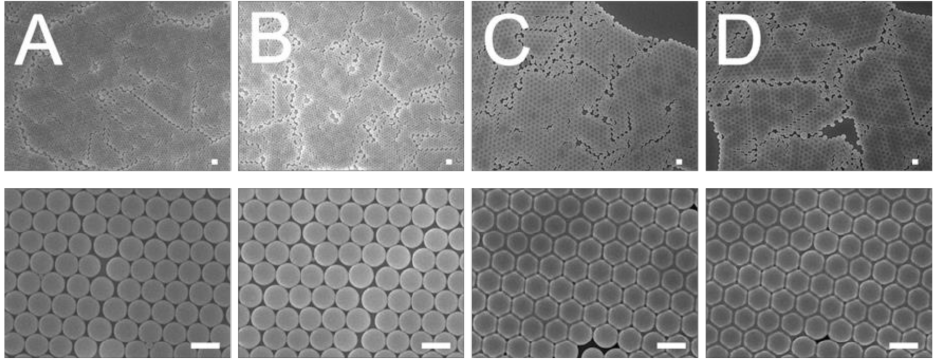
Figure 6. Influence of dispersant content on the assembly of 900 nm nanosphere arrays, ( A ) 7%, ( B ) 10%, ( C ) 30%, ( D ) 40%. (Spin conditions were 500 rpm for 30 s followed by 1500 rpm for 30 s, and 2000 rpm for 60 s. Scale bar: 1 µ m; Magnification: top—3000 × , bottom—15,000 ×